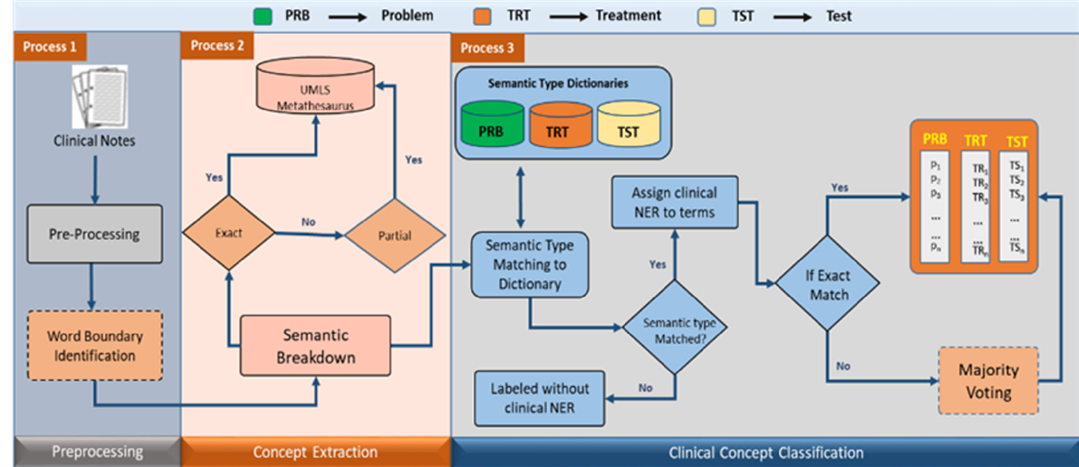
Figure 1. Proposed clinical concept extraction methodology: process 1 involves the preprocessing and word-boundary identification operation; process 2 performs semantic base concept extraction exploiting UMLS; process 3 involves clinical concept